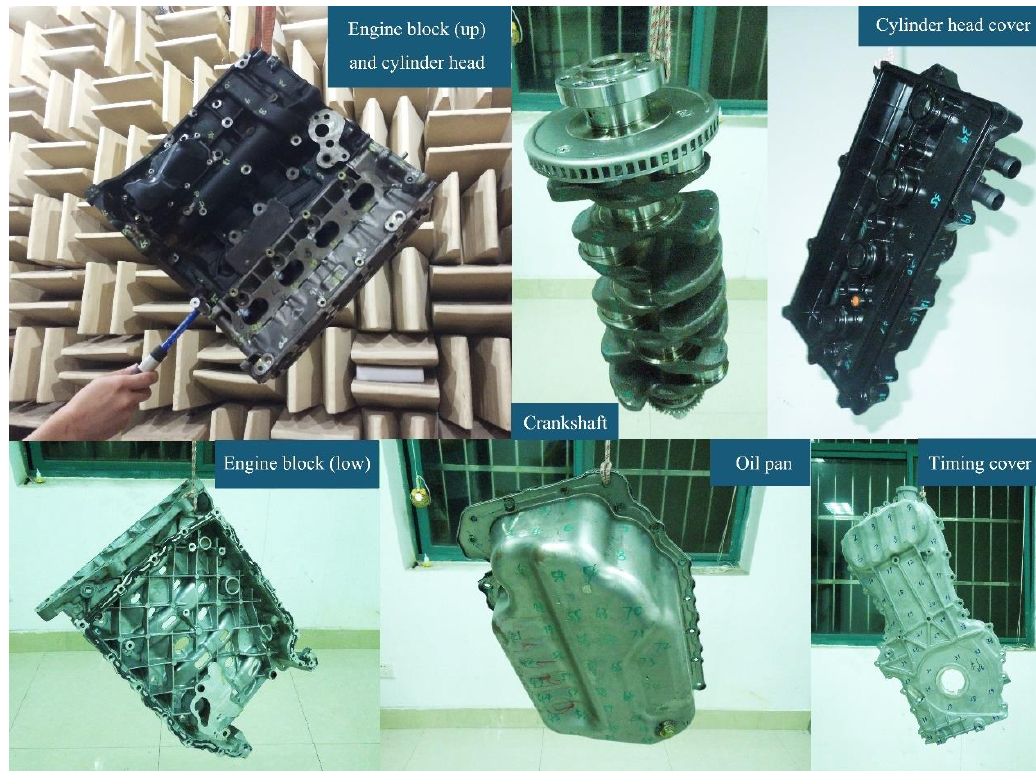
Figure 4. Modal experiments of components.